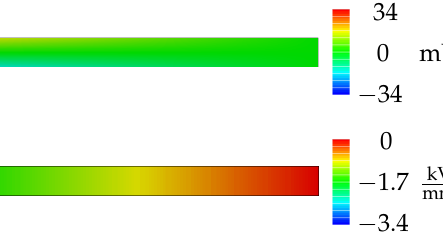
Figure 7. Electric potential φ (top) and electric field E 3 (bottom) distribution in the cantilever